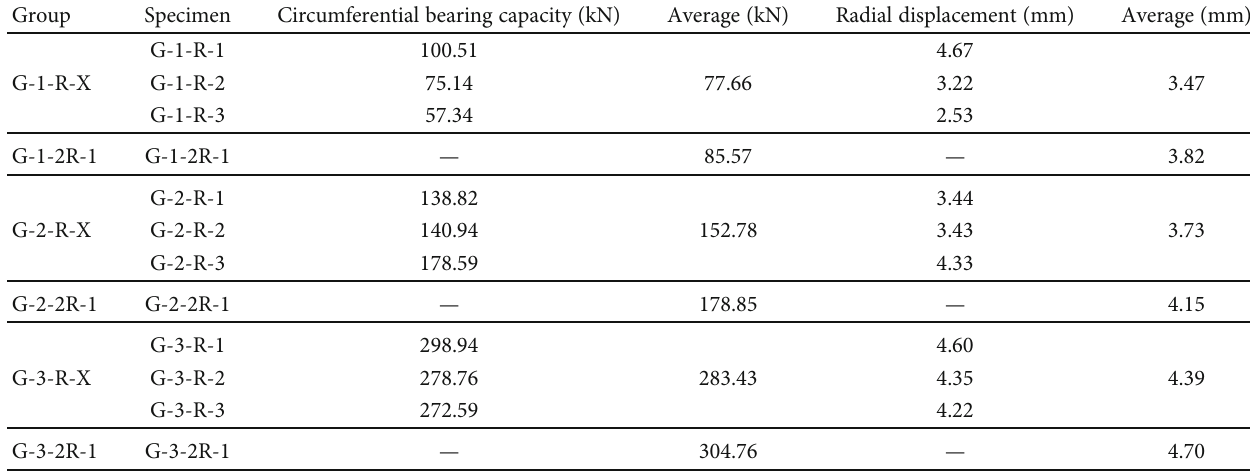
Table 4: Results of circumferential expansion test of rubber belt test group.